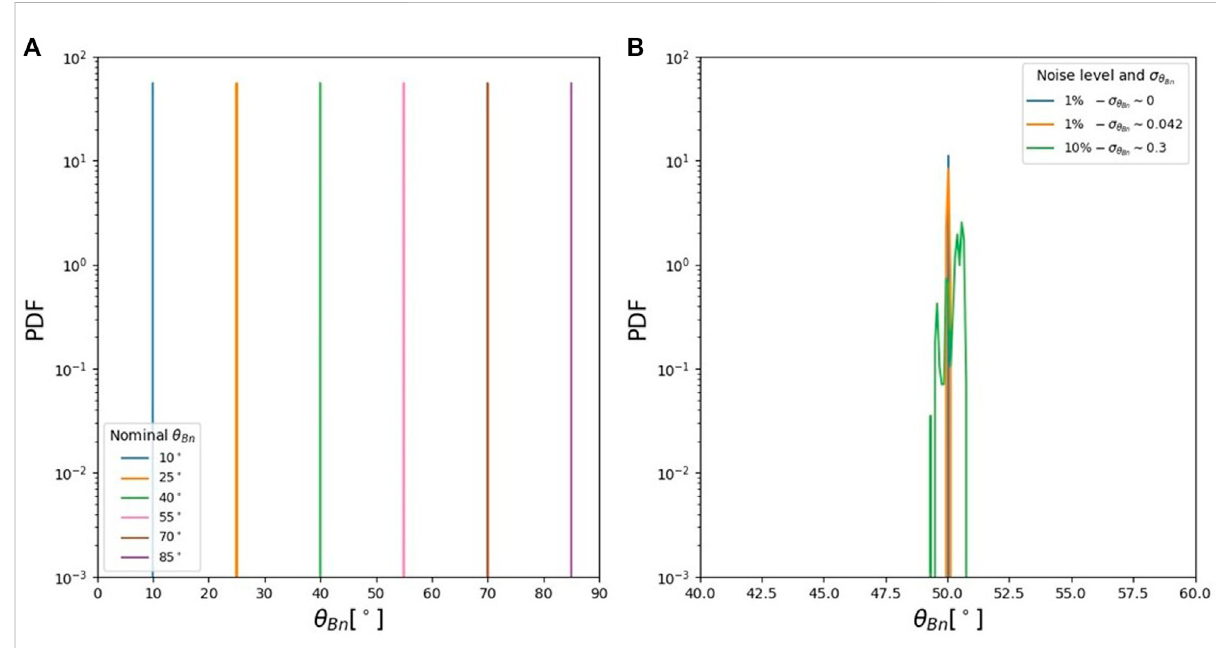
FIGURE 2 (A) PDF distributions for θ Bn computed using magnetic coplanarity and mixed mode techniques, for six different synthetic, Rankine-Hugoniot compliant shocks. (B) PDF distributions of θ Bn for three shocks with the same nominal geometry and different levels of added